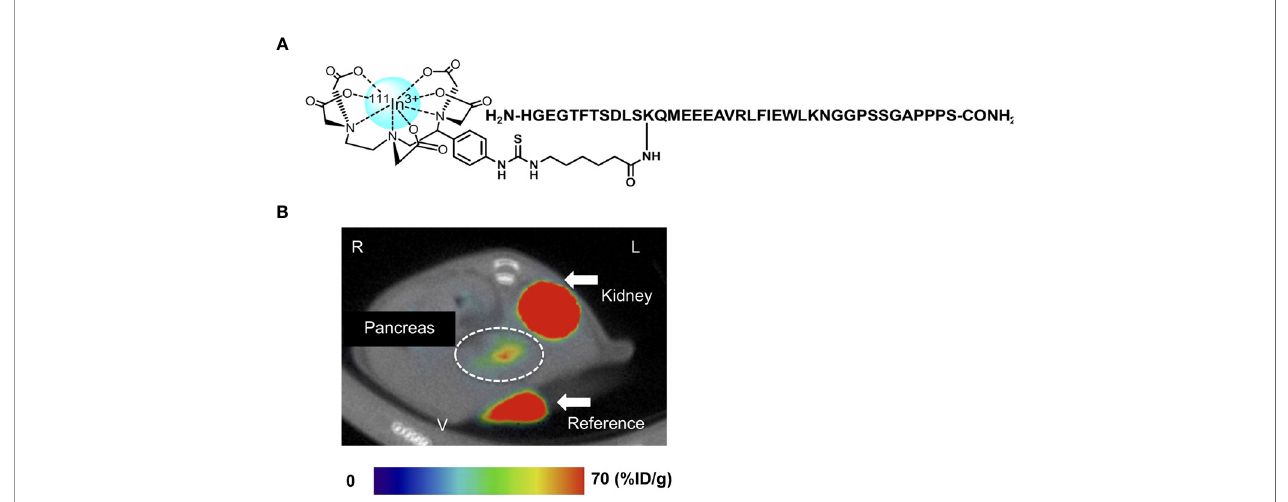
FIGURE 4 | An 111 Indium(In)-labeled exendin-4 derivative: [Lys 12 ( 111 In-BnDTPA-Ahx)]exendin-4. (A) Chemical structure of [Lys 12 ( 111 In-BnDTPA-Ahx)]exendin-4. Exendin-4 was labeled with 111 In via isothiocyanate-benzyl-diethylenetriaminepentaacetic acid (BnDTPA) and 6-aminohexanoic (Ahx) attached to the epsilon amino group at the lysine-12 residue. (B) Representative in vivo axial abdominal image of [Lys 12 ( 111 In-BnDTPA-Ahx)]exendin-4 single-photon emission computed tomography (SPECT)/computed tomography (CT) in a mouse. [Lys 12 ( 111 In-BnDTPA-Ahx)]exendin-4 successfully visualized the pancreas (white dotted circle). Maximum to minimum SPECT intensity: red > orange > yellow > green > blue > black. R, right; L, left; V,